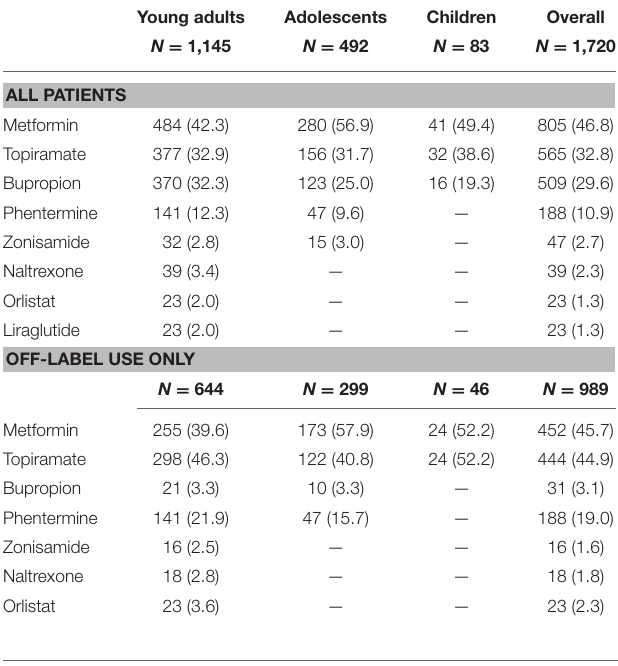
TABLE 3 | Weight loss medications—on and off-label use.